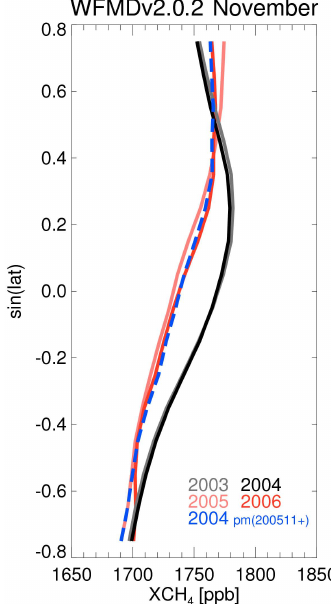
Fig. 13. Reanalysis of a subset of pre-2005 data (November 2004) with the pixel mask since November 2005 (shown in dashed blue) providing monthly latitudinal averages similar to later years with less methane retrieved in the tropics. This suggests that the pixel mask alteration potentially introduces systematic regional